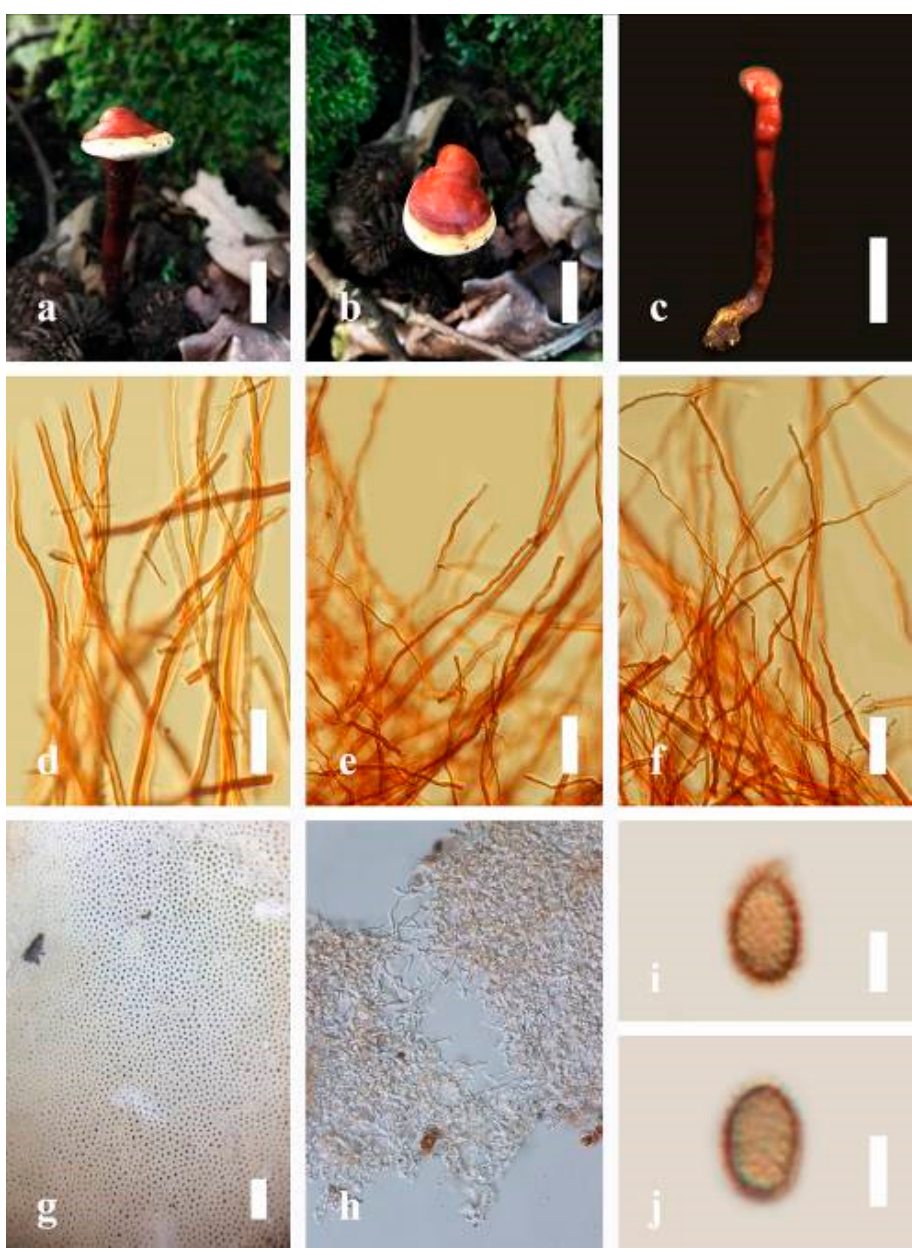
Figure 13. Morphology of Ganoderma sichuanense (HKAS 97398): ( a – c ) mature basidiomes; ( d ) hyphae of trama in KOH; ( e , f ) context hyphae in KOH; ( g ) pore characteristics; ( h ) hyphae of pore in KOH; ( i , j ) basidiospores. Scale bars: ( a , b ) = 1 cm, ( c ) = 3 cm, ( d ) = 20 μ m, ( e , f ) = 30 cm, ( g ) = 1000 μ m, ( i , j ) = 5 μ m. Ganoderma sinense J.D. Zhao, L.W. Hsu and X.Q. Zhang, Acta Mycologica Sinica. 19: 272 (1979) (Figure 14) = Ganoderma formosanum T.T. Chang and T. Chen. Transactions of the British Myco ‐ logical Society. 82(4): 731 (1984) Facesoffungi number: FoF 06253 Description: Basidiomes annual, stipitate, subdimidiate. Pileus 2–6 cm in length, 2–4 cm in width, and 0.3–1 cm thick. Pileus stipitate, subdimidiate to dimidiate, flabelliform, spathulate, umbonate, radial from the center extending to the margin, tough to break when dried, often thick at the center, slightly soft at the margin, light in weight when